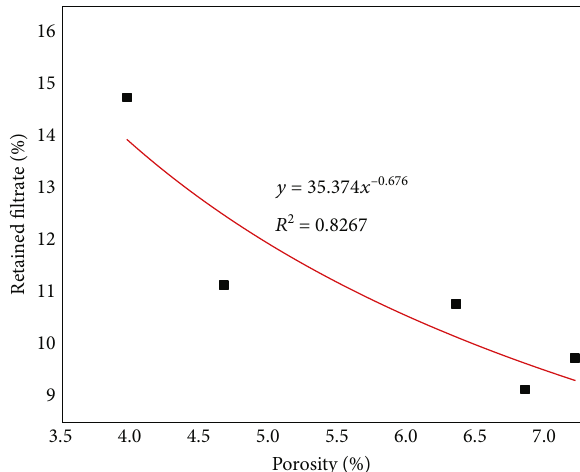
Figure 10: The permeability change before and after core fracturing fl uid